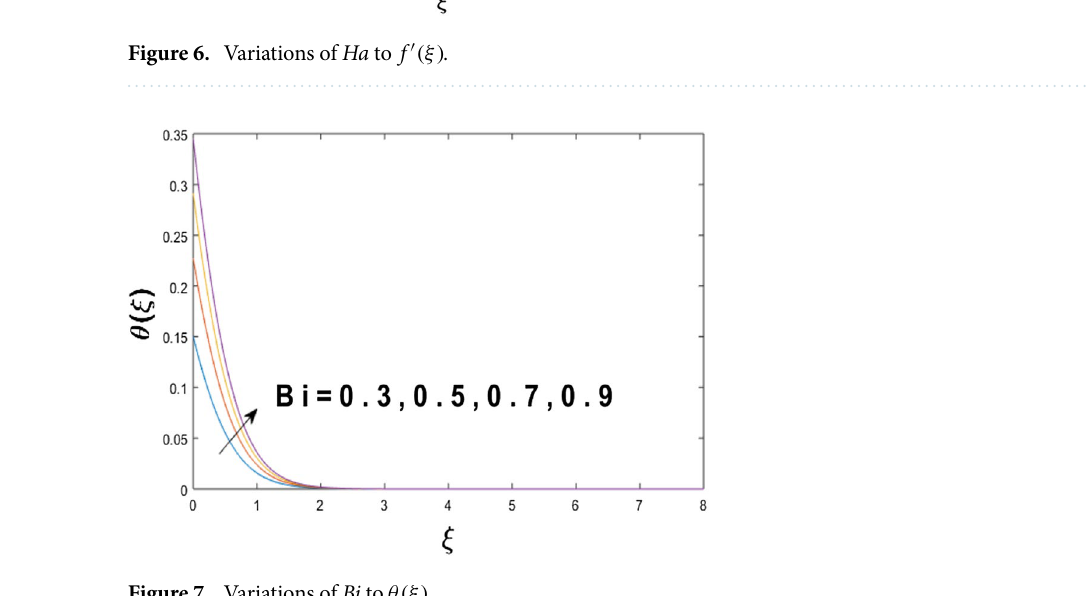
Figure 7. Variations of Bi to θ(ξ) .